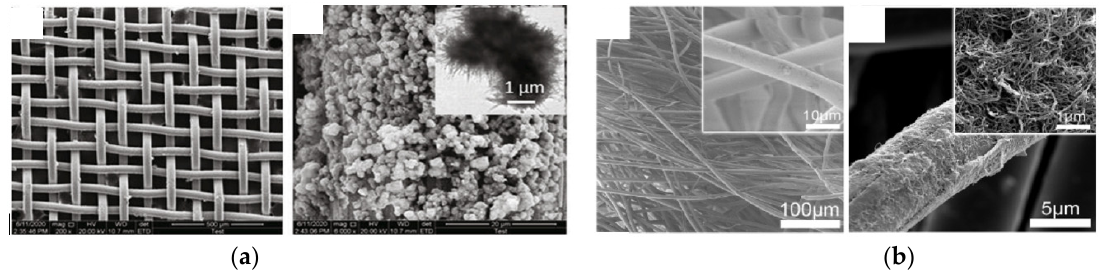
Figure 6. Examples of recent developments toward triboelectric energy harvesting materials and structures for textile application: ( a ) TiO 2 flowers decorating a stainless steel textile (reproduced from [96] with permission from Elsevier); ( b ) CNT decorating a velvet fabric (reproduced from [100] with permission from ACS Publications).